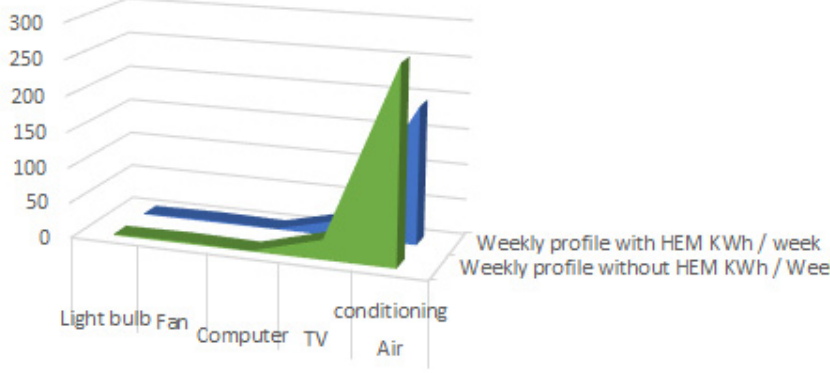
Figure 7. Comparison of weekly consumption by